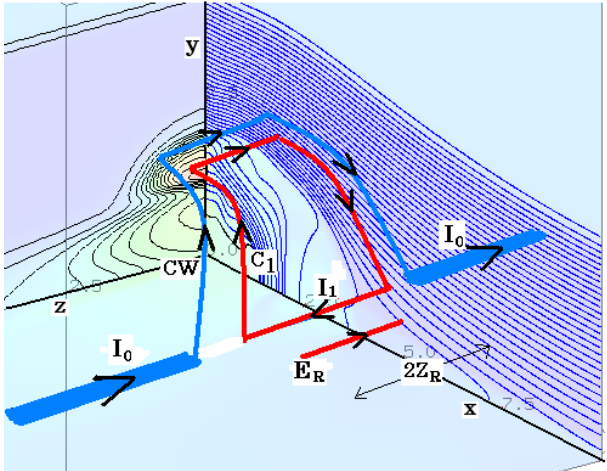
Fig. 13. Schematic drawing of the current circuit C 1 , connected to the MHD generator ahead of the loop top; here, E R ( ∼− u × B ) is the reconnection electric field, 2 Z R is the extent where the fast reconnection proceeds, I 0 is the initial coronal sheet current, and some part of I 0 becomes the current wedge, CW